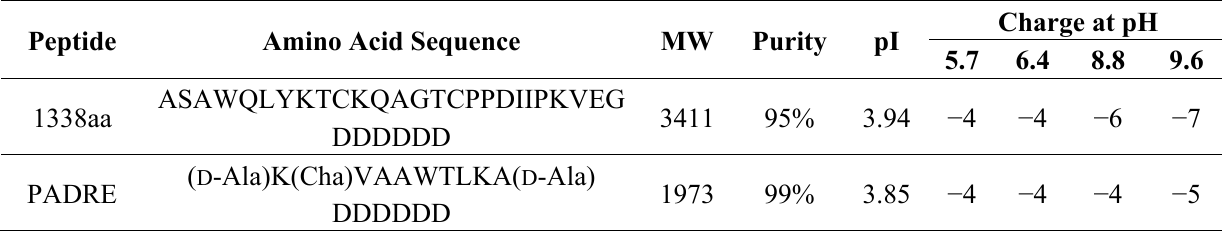
Table 1. Physicochemical characteristics of the